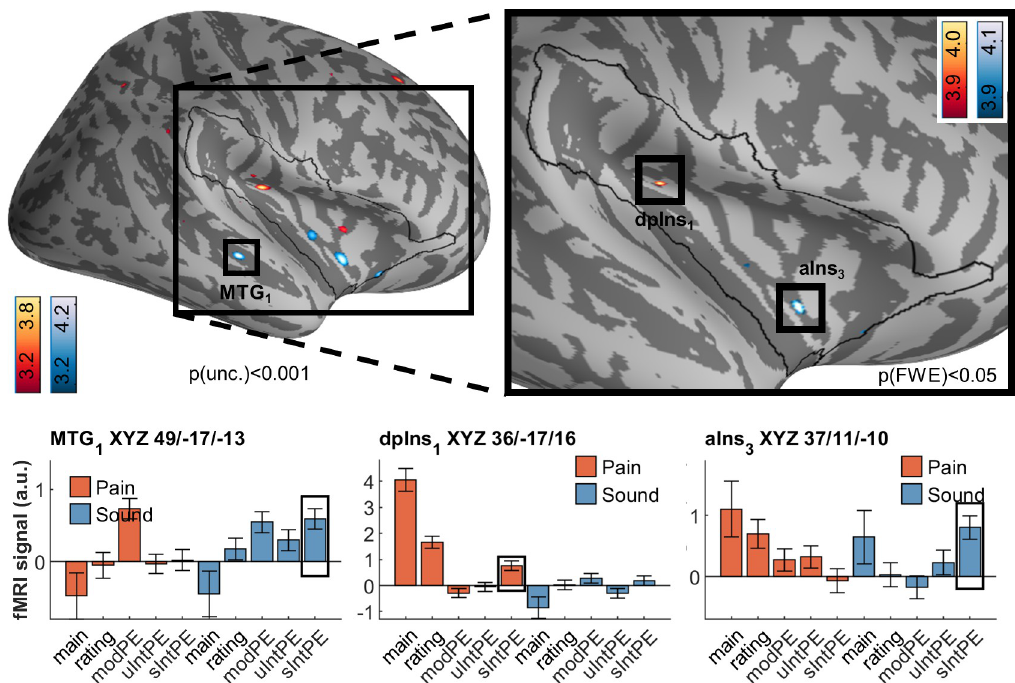
Fig 9. Brain activation associated with by signed intensity prediction errors in pain (red/yellow) and sound (blue), including overlaps as per conjunction analyses (green). Contrary to uIntPEs, circumscribed activation was detected for pain sIntPEs without any overlap with sound sIntPEs. Peak activation is located in the dorsal posterior insula (dpIns 1 ). For sound, several clusters in the anterior insula (e.g., aIns 3 ) were found, as well as middle temporal gyrus (MTG 1 ). Activations are overlaid on an average brain surface; for display purposes, activations in the whole brain lateral view are thresholded at p [uncorr.] < 0.001. The black line in the zoomed-in view delineates the region of interest and includes activations within the small volume FWE corrected at p[corr.] < 0.05. In the fMRI signal bar graphs, black rectangles highlight the individual regressors used for analysis. fMRI signal labels refer to the regressors used for each modality: “main” for main effects of modality, “ratings” for behavioral ratings, “modPE” for modality PEs, “uIntPE” for unsigned intensity PEs, and “sIntPE” for signed intensity PEs. Data used to produce the figure can be found at https://www.doi.org/10.17605/OSF.IO/7JBV3. fMRI, functional magnetic resonance imaging; FWE, family-wise error; PE, prediction